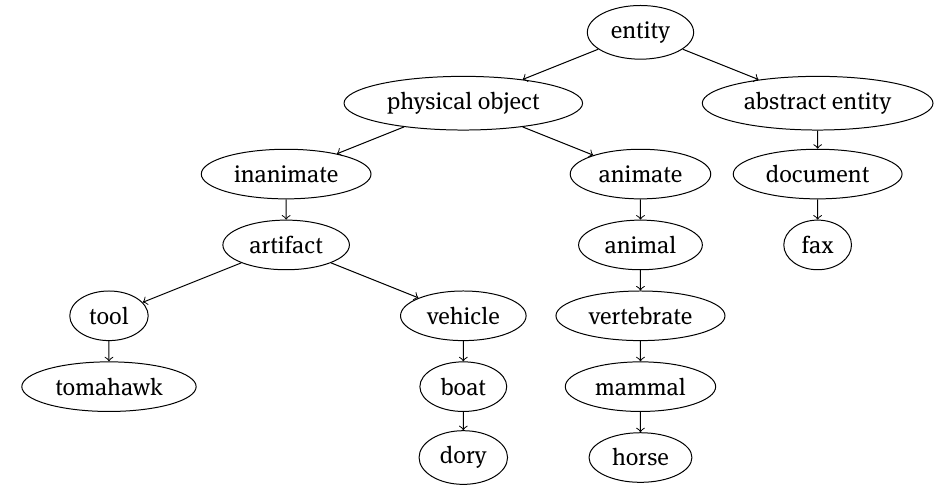
Figure 5: Some examples of results of the algorithm that are in disagreement with the gold standard due to polysemy